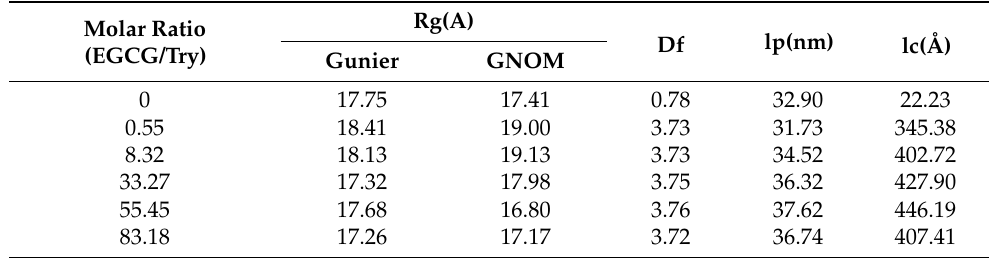
Table 1. The SAXS derived parameters (Rg, Df, lp, and lc) at different molar ratios of EGCG/trypsin.